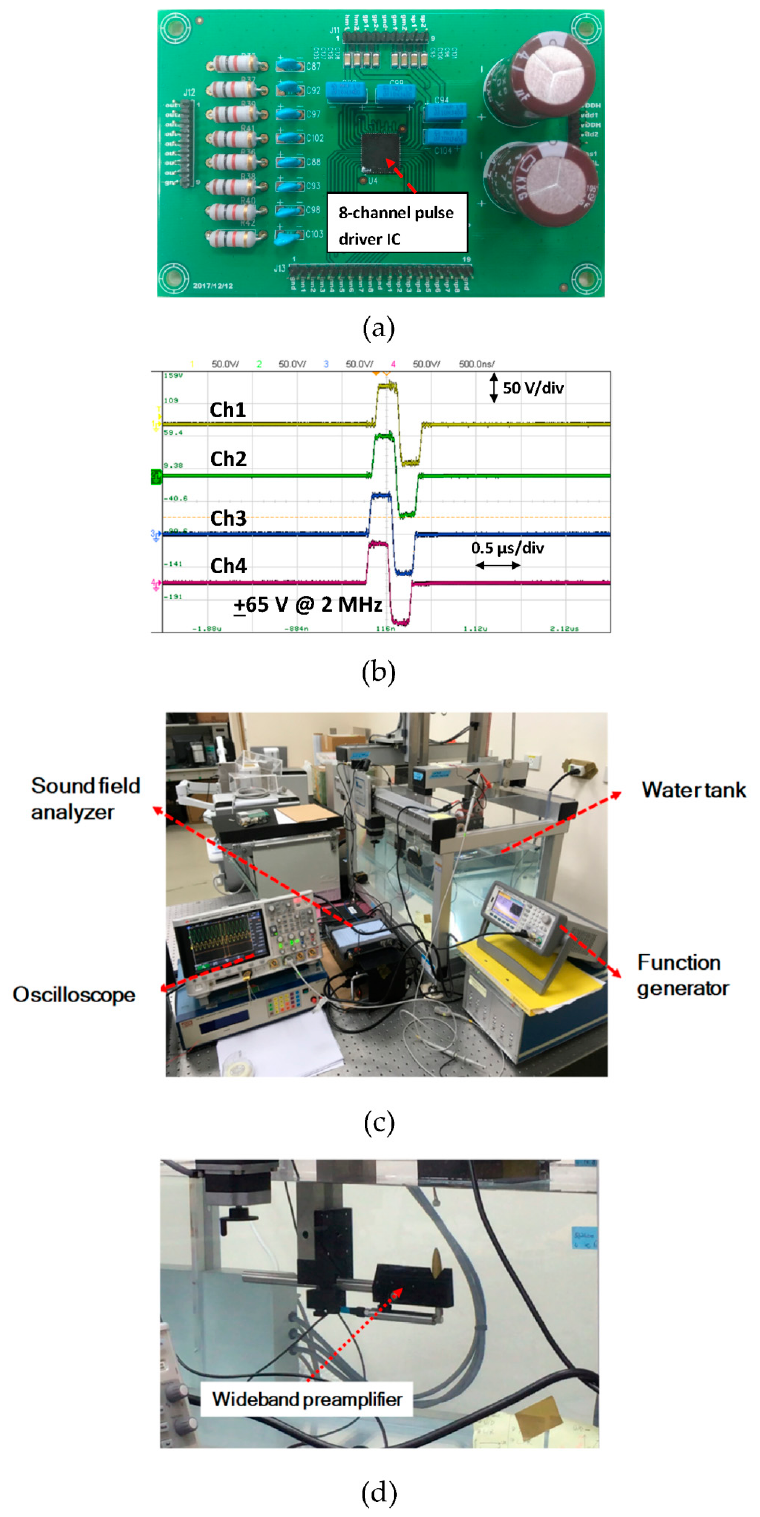
Figure 21. The eight-channel pulse driver integrated circuit in a single package and its assembly ( a ), multiple-channel delayed high-voltage pulses ( b ), the Acoustic Intensity Measurement System (AIMS) and the associated equipments ( c ) and the wideband receiver of the sound field measurements ( d ).